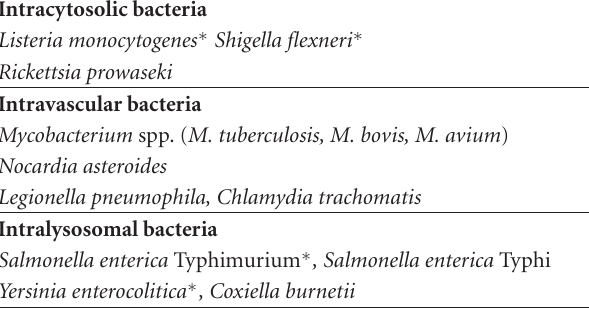
Table 1: Intracellular